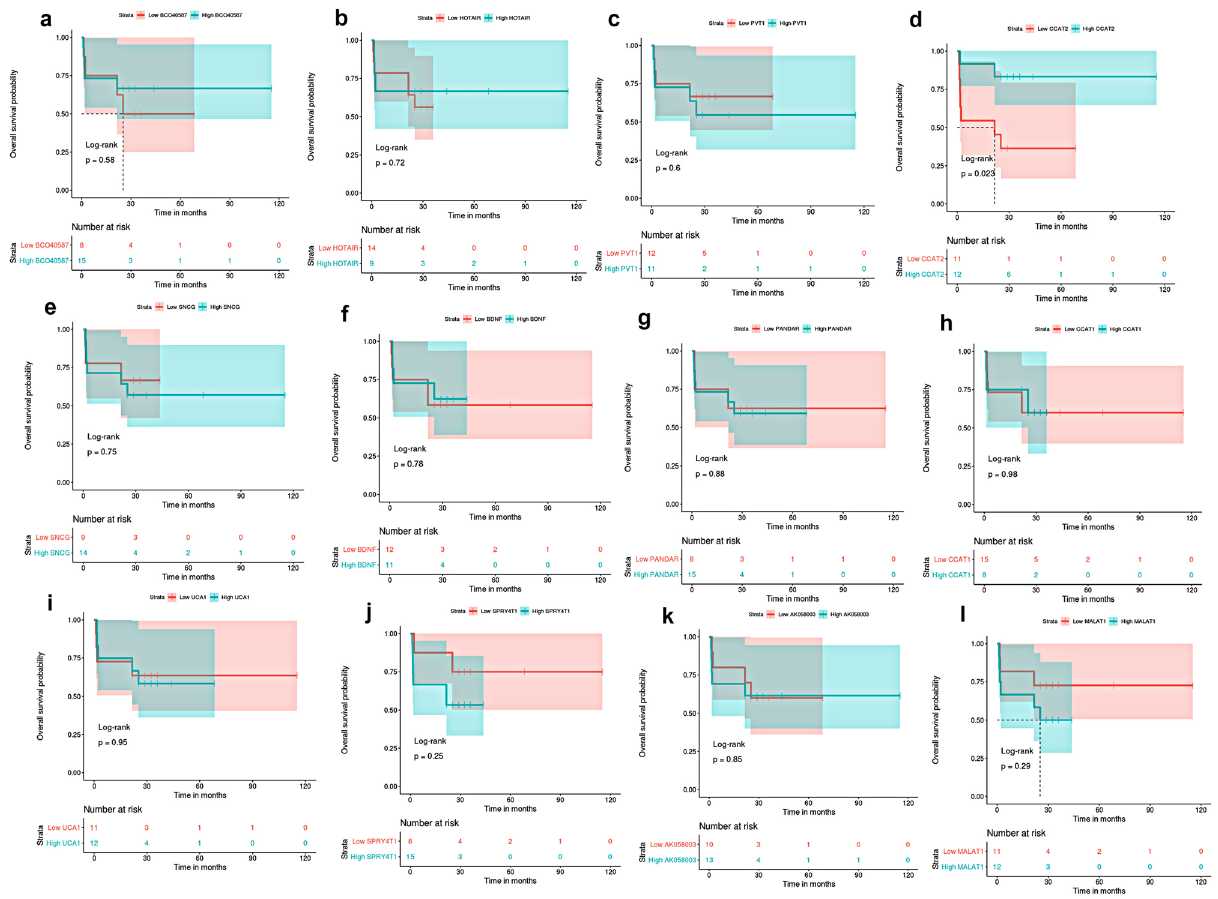
Figure 5. Kaplan Meier overall survival analysis of non-metastatic breast cancer patients in relation to lncRNAs (BCO40587, HOTAIR, PVT1, CCAT2, PANDAR, CCAT1, UCA1, SPRY4-IT1, AK058003 and MALAT1) and mRNAs (SNCG and BDNF) expression